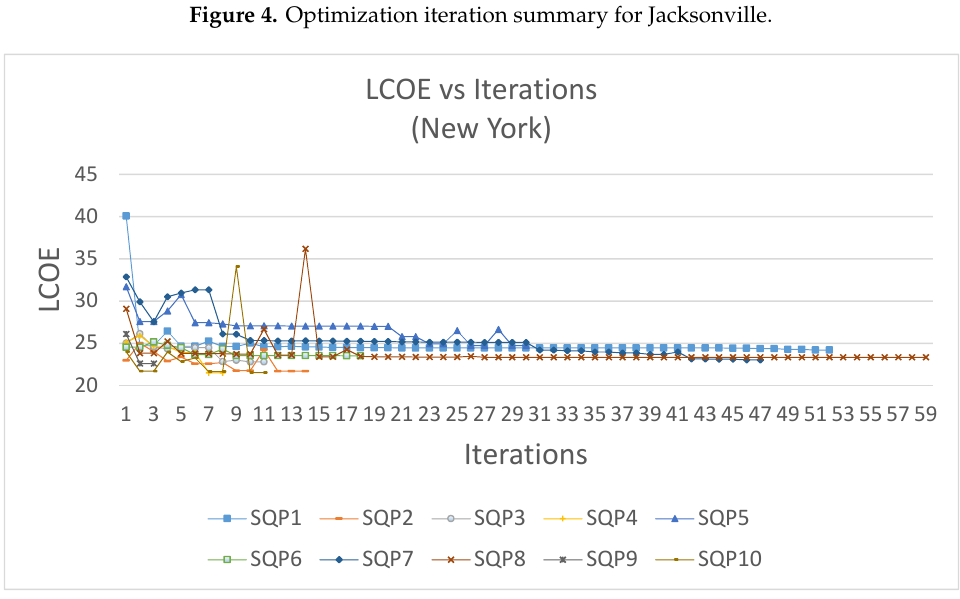
Figure 5. Optimization iteration summary for New York. 397 Table 3. Optimal values and cost savings for di ff erent locations with consideration of